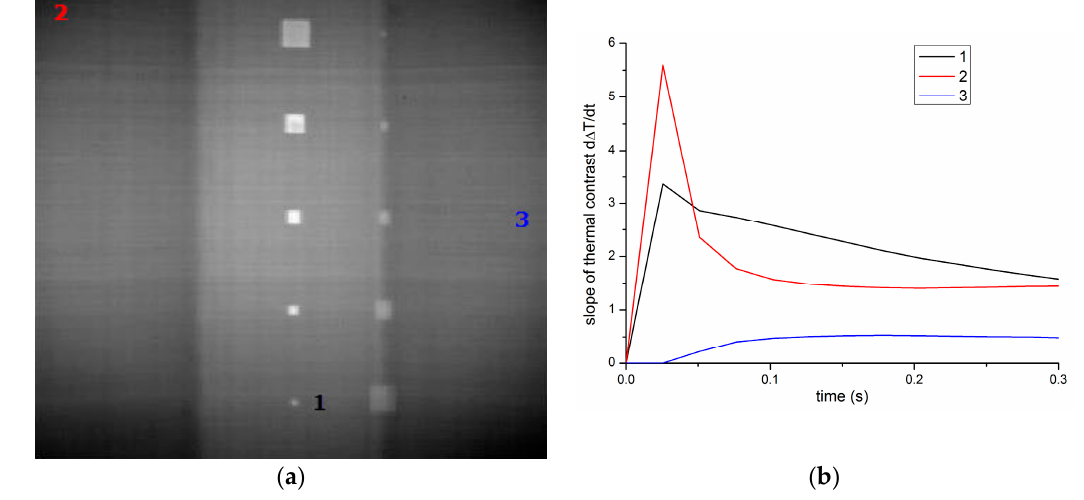
Figure 13. ( a ) Thermal image of the inspected surface showing the regions from which sound areas 1,2, and 3 were selected to calculate the slope of the thermal contrast for Defect A1; and ( b ) temporal evolution of the correspondent thermal contrast slope curves.